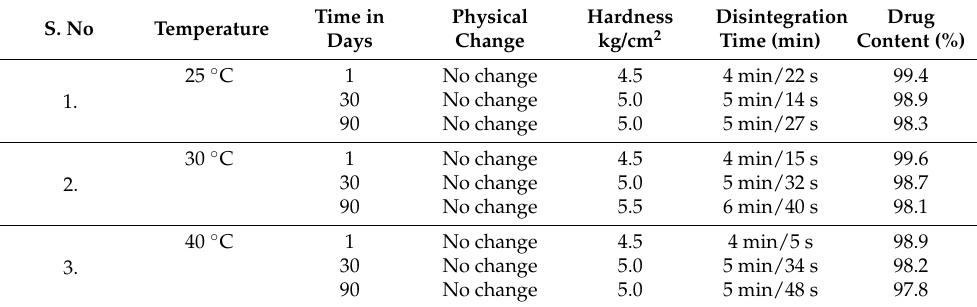
Table 13. Accelerated stability studies of F2.